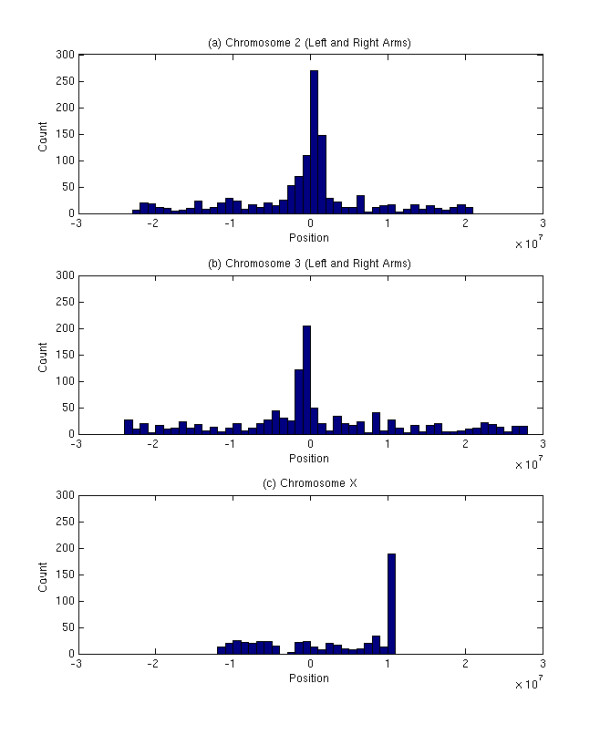
Density of LTRs as a function of chromosomal position in chromosome II (a), chromosome III (b), and chromosome X (c) of D. melanogaster. The left sides of 0 in (a) and (b) are from left arms and the right sides of 0 in (a) and (b) are from right arms. The middled point of X chromosome is defined as 0 for the comparison. High densities of LTRs are observed in the pericentromeric regions of all three chromosomes.